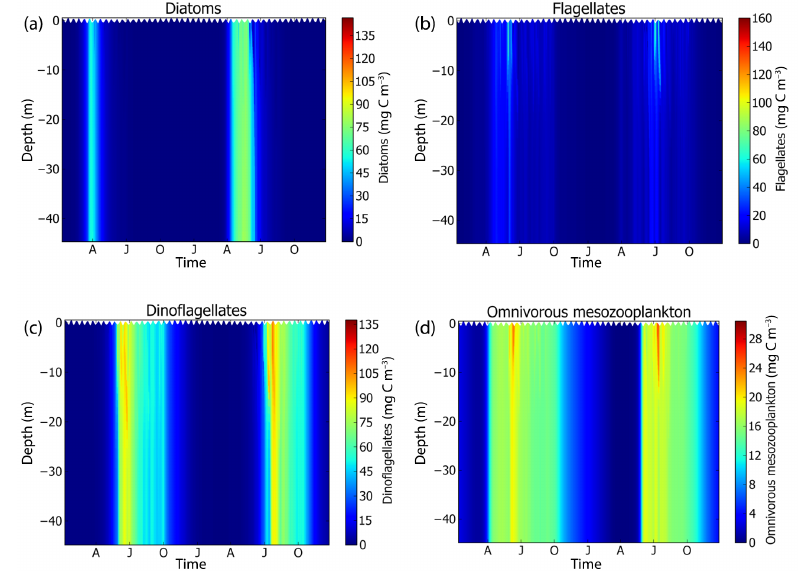
Figure 3. GOTM–ERSEM prediction for the dynamics of four Plankton types – (a) diatoms, (b) flagellates, (c) dinoflagellates, and (d) om- nivorous mesozooplankton within a water column over a 2-year period using synthetic meteorological data